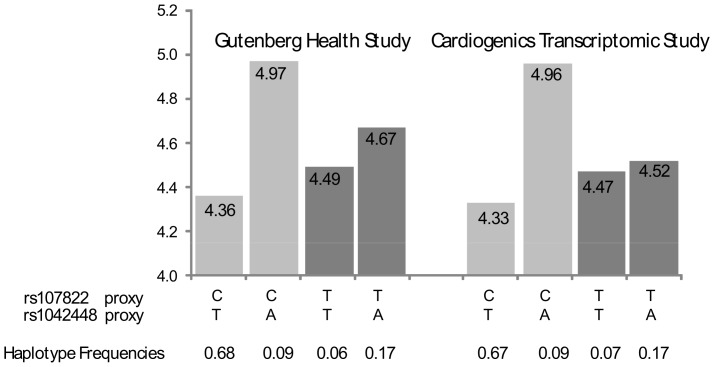

HLA-DPB1 rs1042448 × hsa-mir-219-1 rs107822 interaction on HLA-DPB1 monocyte expression.In the Gutenberg Health Study, the rs1042248/rs107822 pair was tagged by rs3128923/rs213208. In the Cardiogenics Transcriptomic Study, the corresponding tagging pair was rs3117222/rs439205.